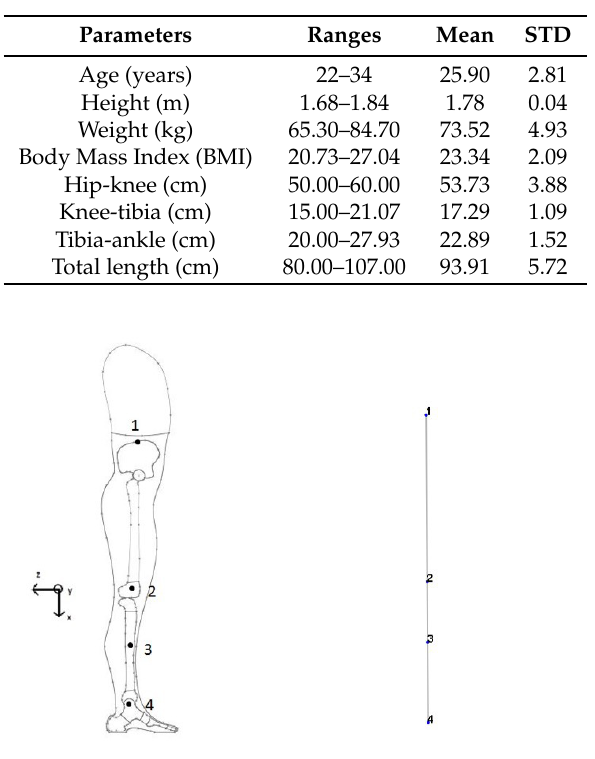
Table 1. Subjects’ anthropometric parameters.